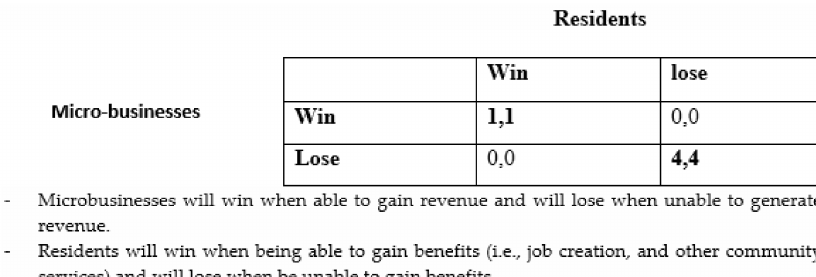
Figure 1. Non-zero game theory.